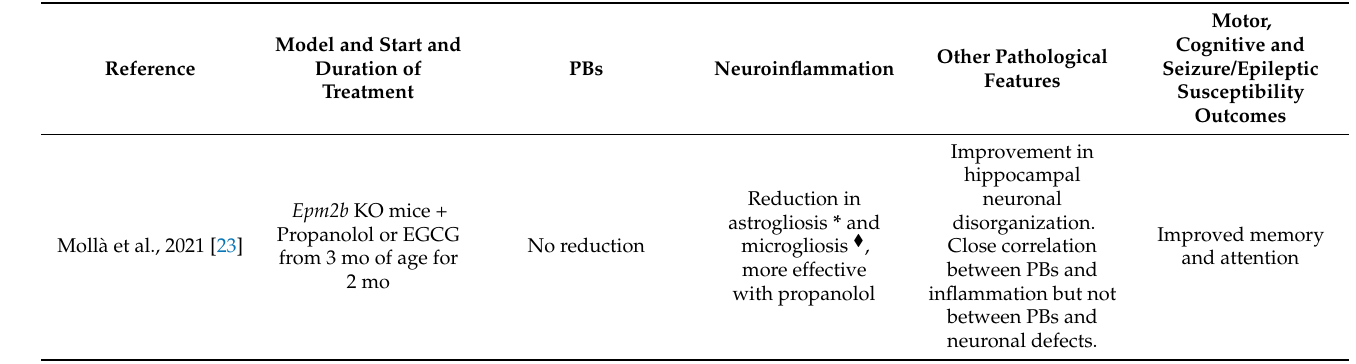
Table 3. Summary of studies describing alternative therapeutic strategies to the inhibition of glycogen synthesis in animal models of